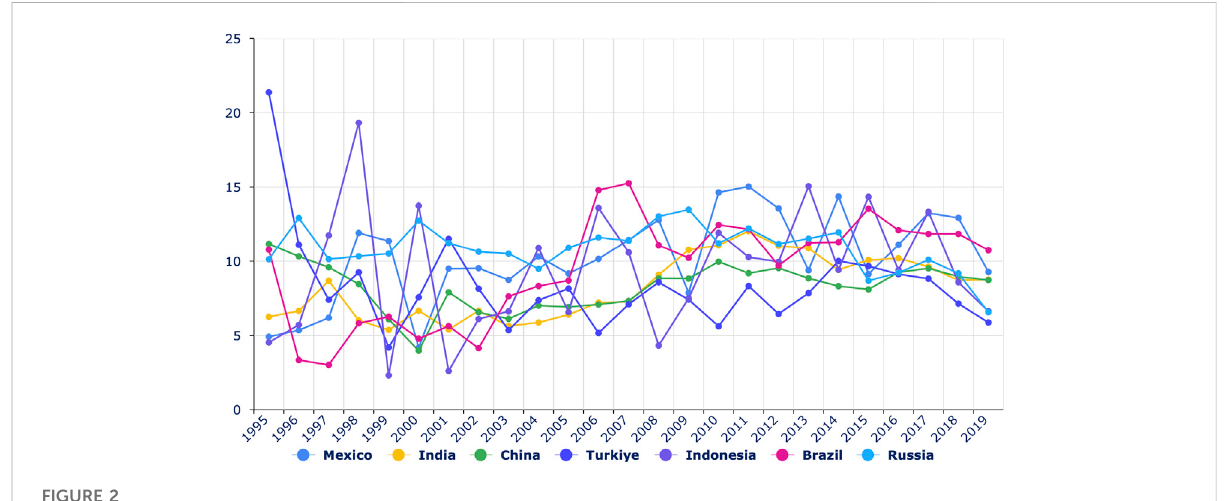
FIGURE 2 Tend of patents in E-7 countries (1995 –